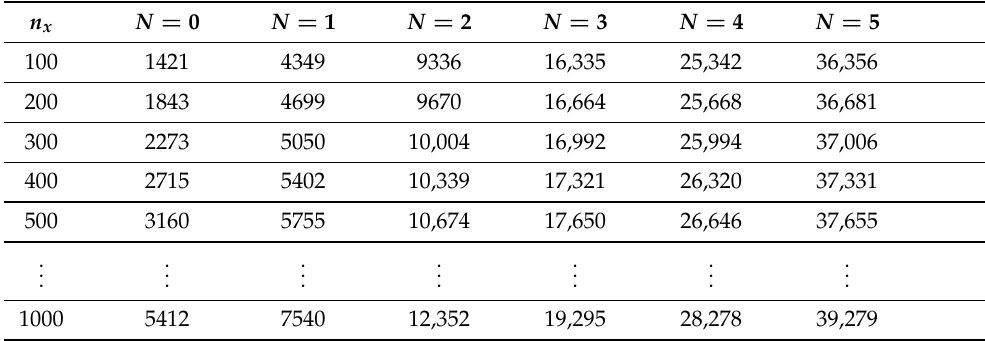
Table A3. Fastest eigenvalue Λ max for different n x , N , and constant λ = 10 − 4 . For a visualization, see Figure 7.